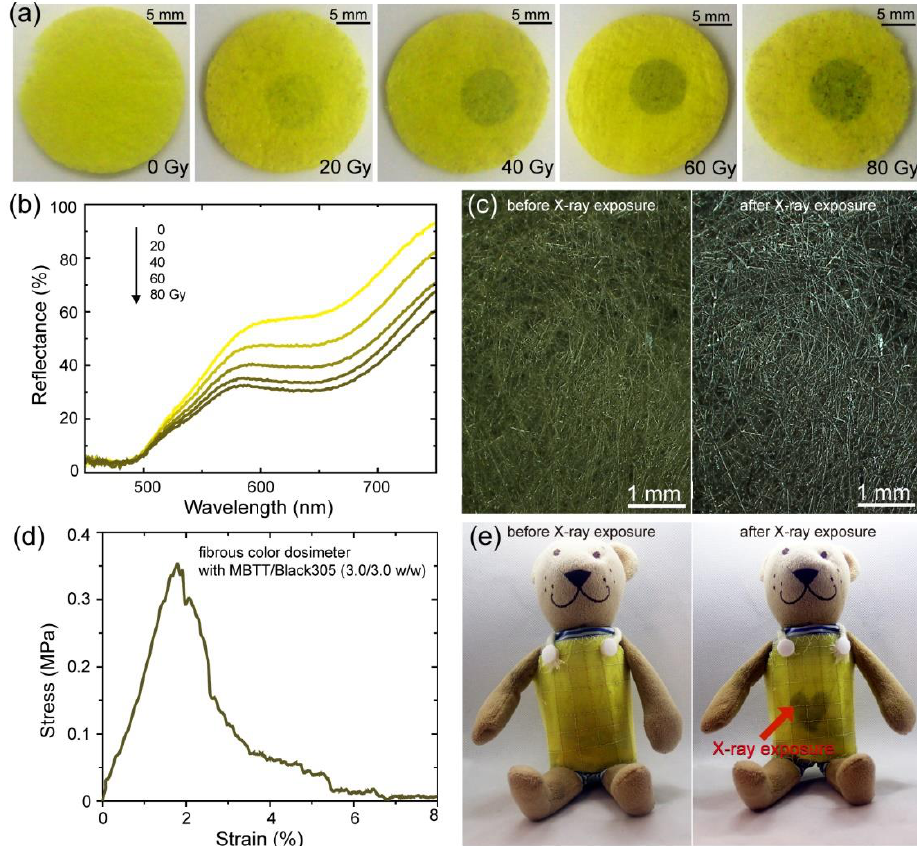
Figure 3. ( a ) Photographs of color changes of the fibrous color dosimeter with a MBTT / Black305 ratio at 3.0 / 3.0 w / w for each X-ray exposure dose. Black areas indicate the spot that is irradiated with the X-ray exposure. ( b ) The change in the reflectance spectrum of the fibrous color dosimeter with a MBTT / Black305 ratio at 3.0 / 3.0 w / w during X-ray exposure doses. ( c ) Photograph showing the aspect of the fibrous color dosimeter with a MBTT / Black305 ratio at 3.0 / 3.0 w / w before and after X-ray exposure for 80 Gy. ( d ) Stress–strain curve of the fibrous color dosimeter. ( e ) Photographs of the clothlike fibrous color dosimeter with a MBTT / Black305 ratio at 3.0 / 3.0 w / w (left) before and (right) after X-ray exposure through the lead sheet cut in a “ ”